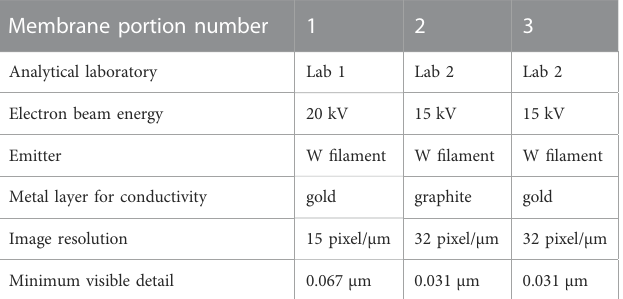
TABLE 1 Instrumental conditions used in the study to perform waterborne asbestos